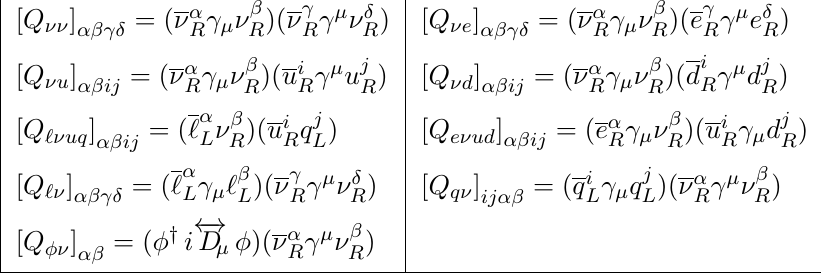
Table 3 . Dimension-six operators containing right-handed